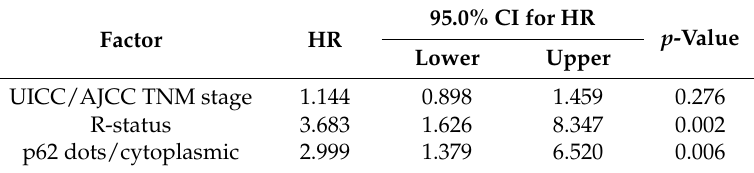
Table 2. Results of multivariate analysis including UICC/AJCC TNM stage.